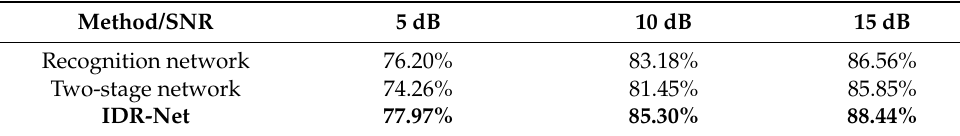
Table 7. Comparisons of the recognition accuracy for SNR of 5 dB, 10 dB, 15